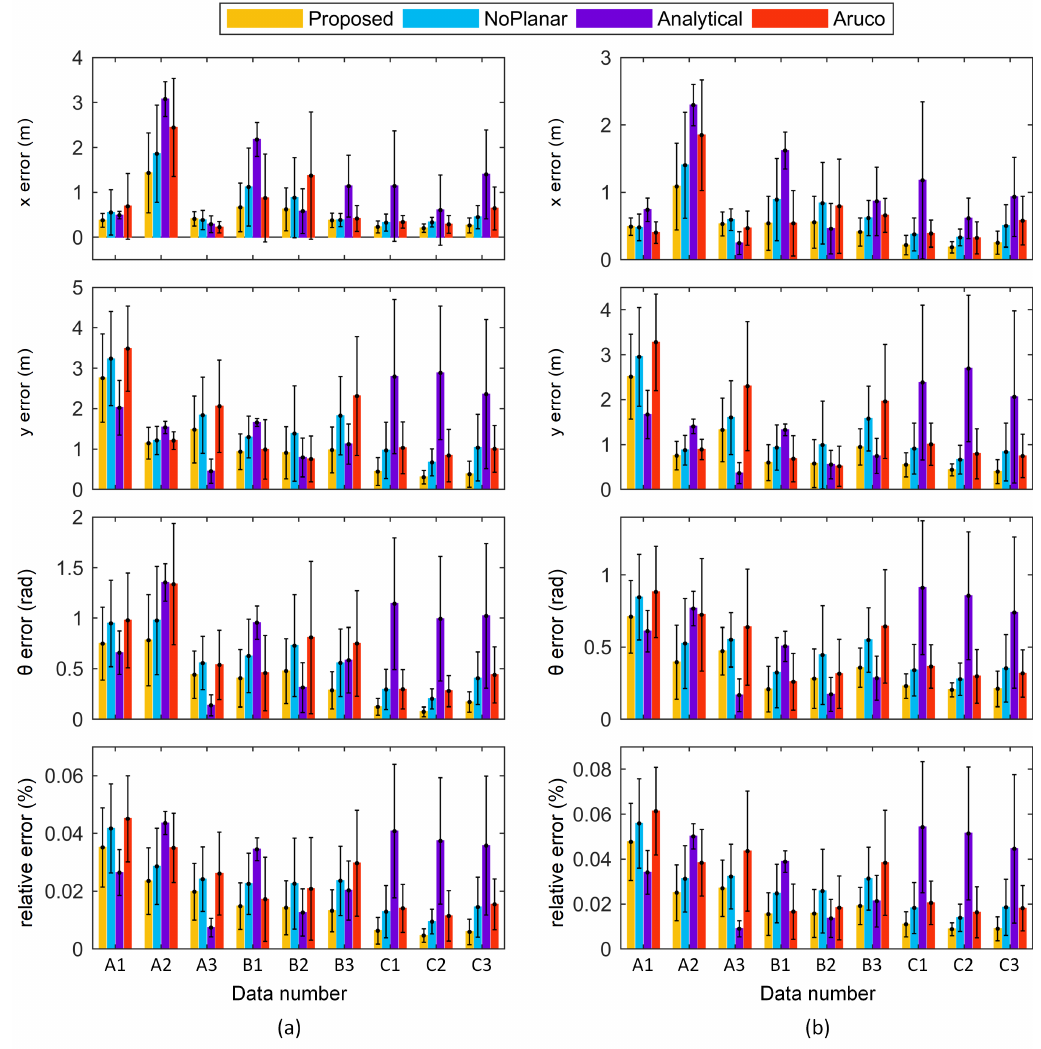
Figure 9. Odometry errors of different methods with different data using trajectories ( a , b ) from Figure